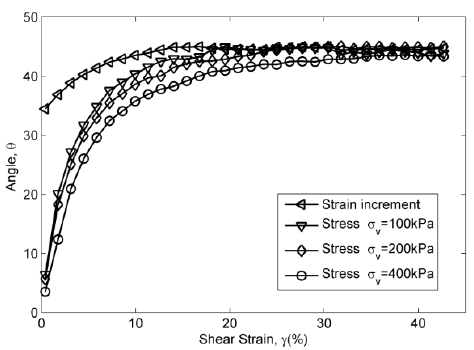
Figure 14. Rotation of principal axes of stresses and strain increment under different vertical stresses [60].